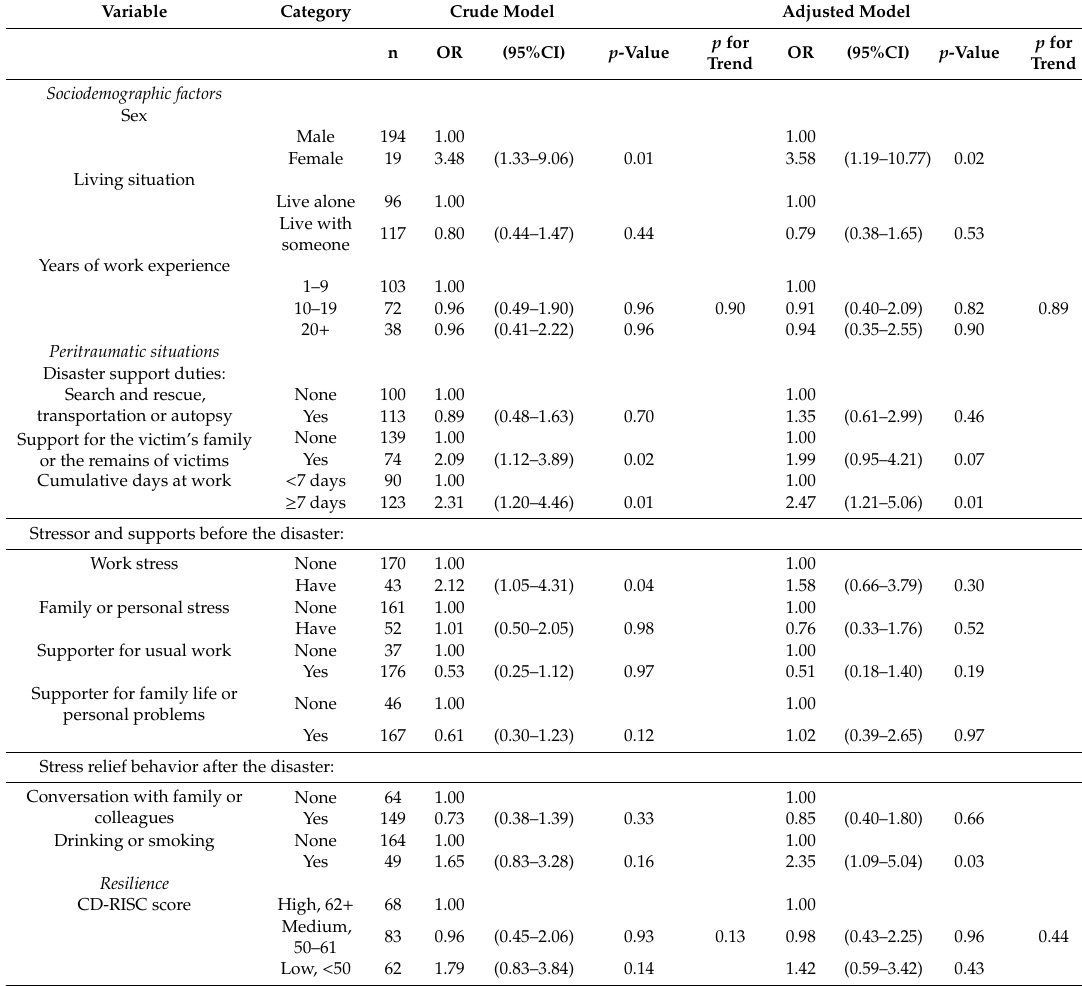
Table 2. The relationship between a posttraumatic-stress diagnostic scale (PDS) score greater than one and the peritraumatic situation of disaster support work among participants with symptoms after the Mt. Ontake eruption